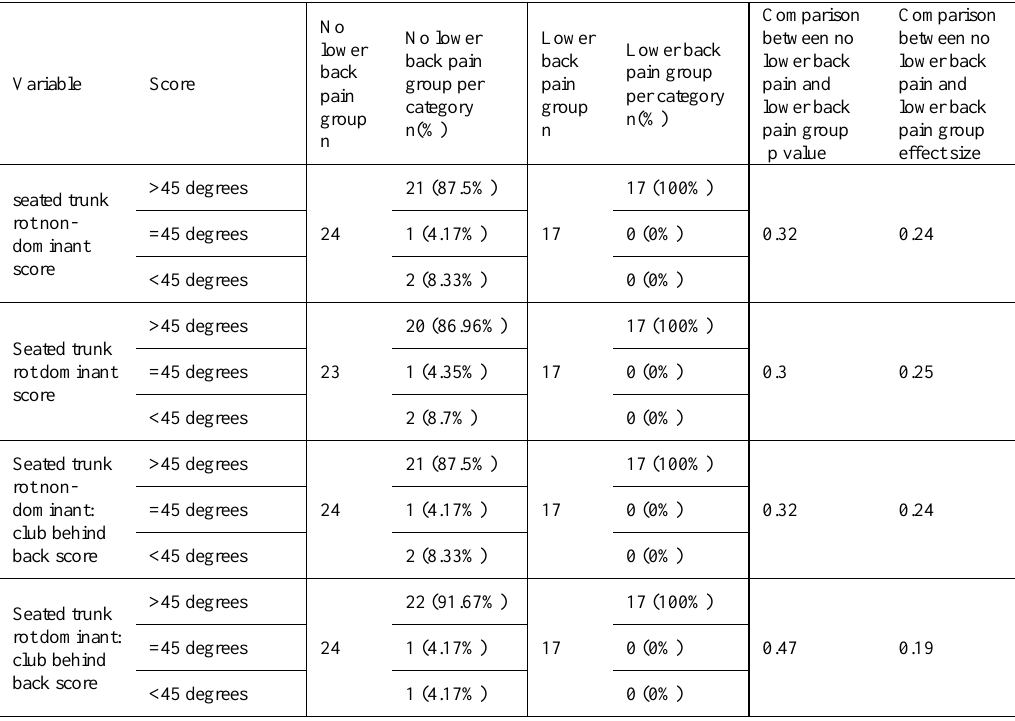
Table notes: Data presented as number (n) per category and percentages. p value calculated using Pearson Chi Squared Test and Fishers exact